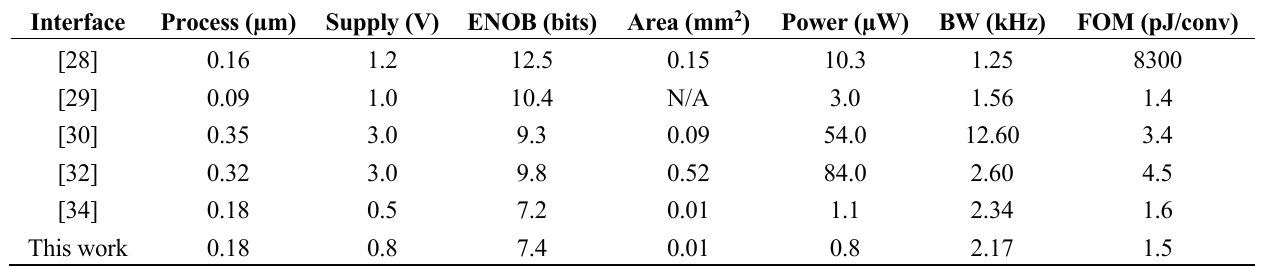
Table 1. Performance comparison of integrated sensor